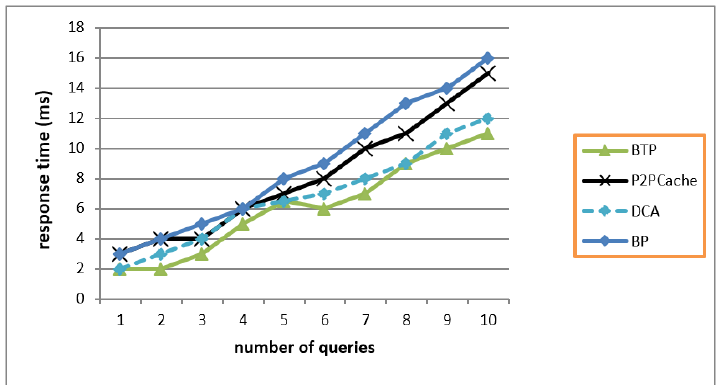
Figure 16. Response Time of user’s queries.